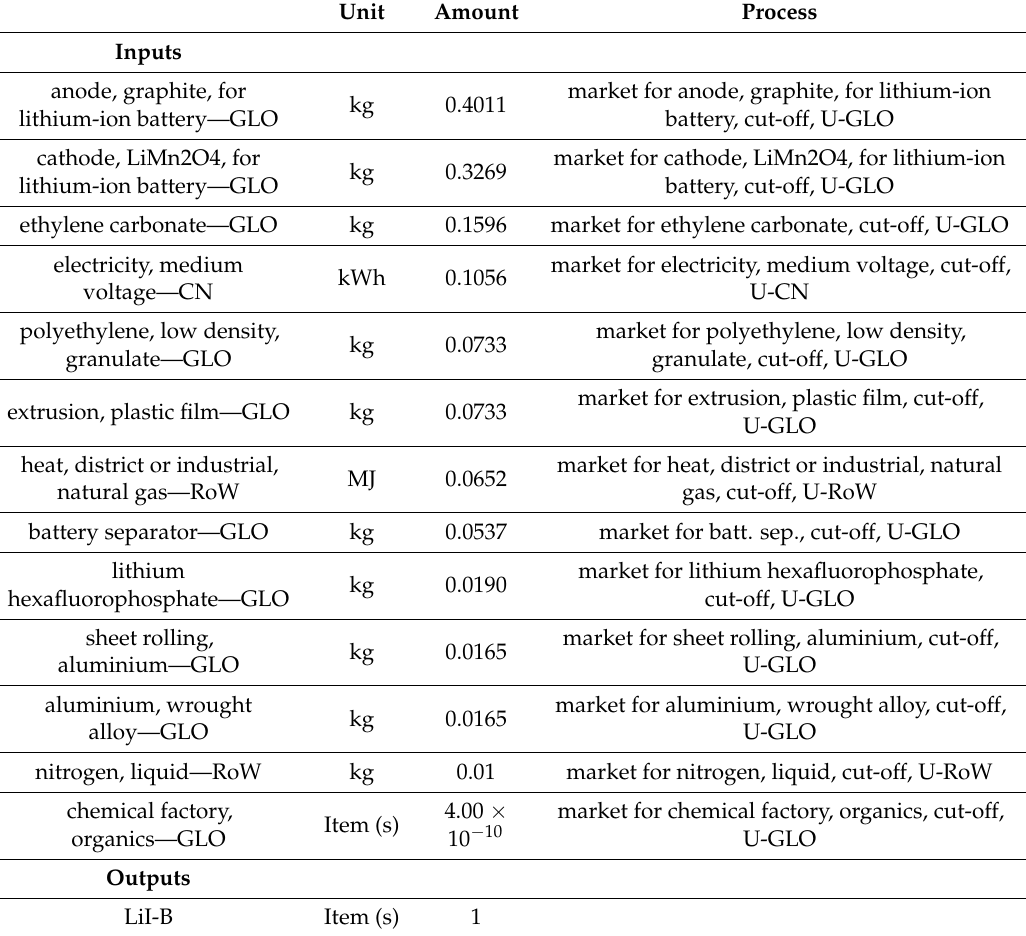
Table A24. Manufacturing, LiI-B.